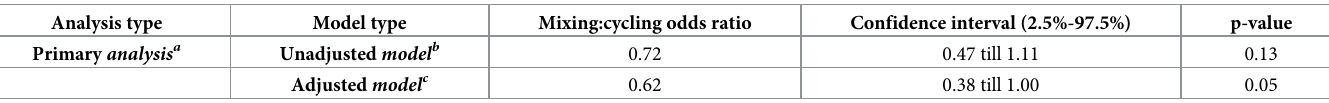
Table 4. Mixed effects logistic regression odds